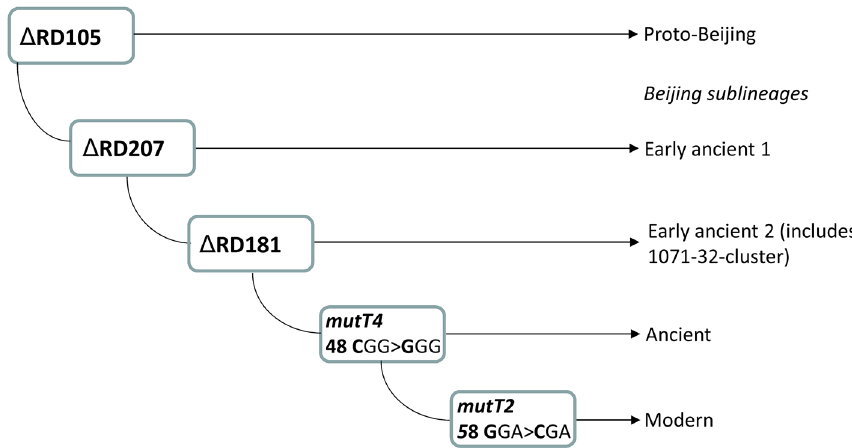
Figure 1. Simplified evolutionary pathway of the M. tuberculosis Beijing genotype. Digital profile of the 1071-32-cluster: 244231342644425173353923 (loci are listed in clockwise order on